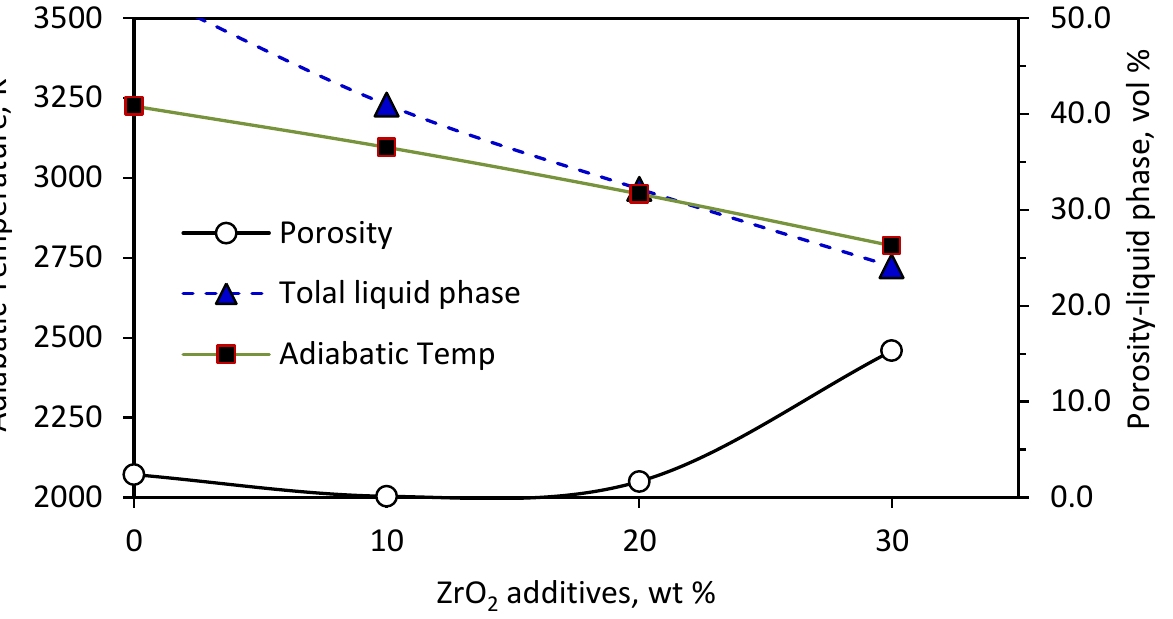
Figure 5. Effect of ZrO 2 amounts on the ZrN/ZrSi 2 - samples’ porosity prepared at 234 MPa, total liquid phase and adiabatic temperature.